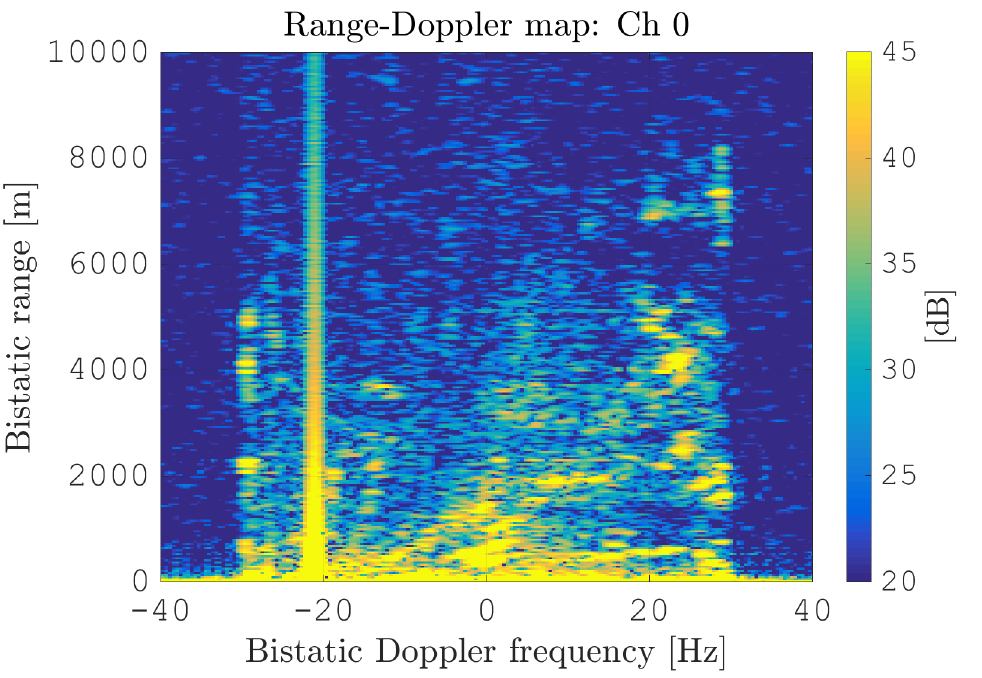
Figure 9. Initial range-Doppler map for the leading